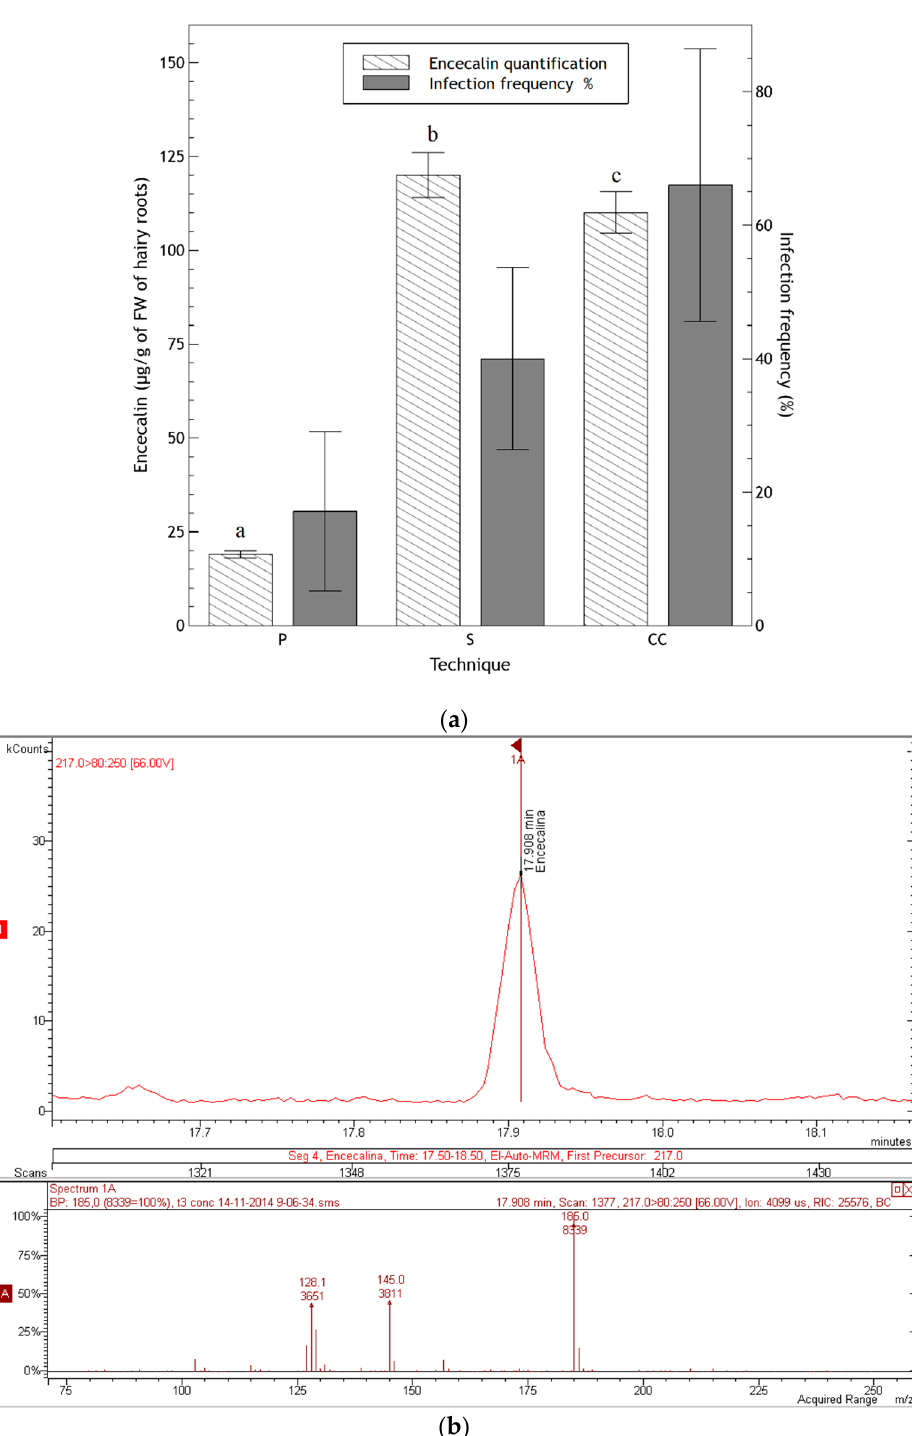
Figure 8. ( a ) Encecalin quantification in hairy roots (three months old) and percentage of transformation in three assays: prick (P), sonication (S) and co ‐ culture (CC). Data of transformation frequency represent the average ± SD of five measurements. Data of encecalin quantification represent the average ± SD of three injections. Different letters indicate significant differences in encecalin production after a one ‐ way ANOVA following by Tukey test ( p < 0.05); ( b ) chromatogram of a sample of hairy roots (three months old) from co ‐ cultivation where the peak of encecalin can be seen, as well as spectra of masses ‐ masses obtained by fragmentation of the ion of mass 217. Encecalin production significantly varied in relation to the method used for H. quinquenervis transformation as determined by one ‐ way ANOVA (F(2,6) = 457.9; p < 0.0001). Although co ‐ culture